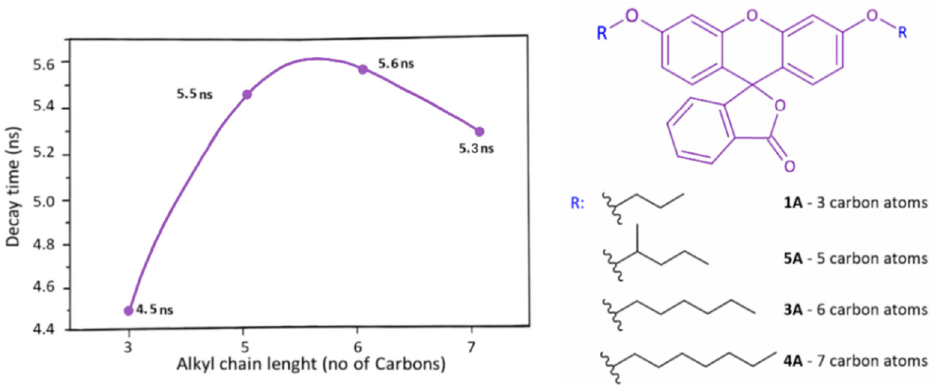
Figure 6. Decay times as function of alkyl chain length for derivatives A .